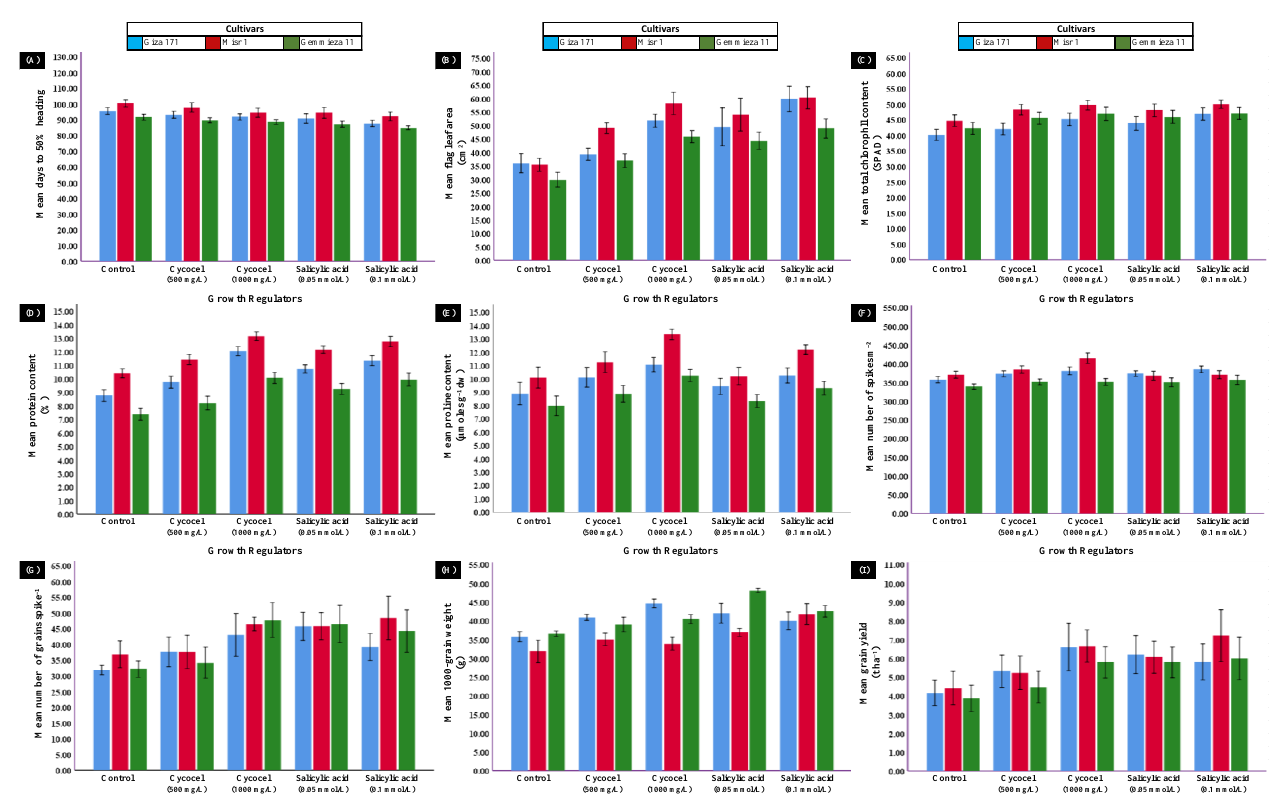
Figure 2. Error bar chart showing the effect of the interaction between cultivars and growth regulators on ( a ) mean days to 50% heading, ( b ) mean flag leaf area (cm 2 ), ( c ) mean total chlorophyll content (SPAD), ( d ) mean protein content (%), ( e ) mean proline content (µmoles g −1 dw), ( f ) mean number of spikes cm −2 , ( g ) number on grains spike −1 , ( h ) mean 1000 grain weight (g), ( i ) mean grain yield (t ha −1 ).